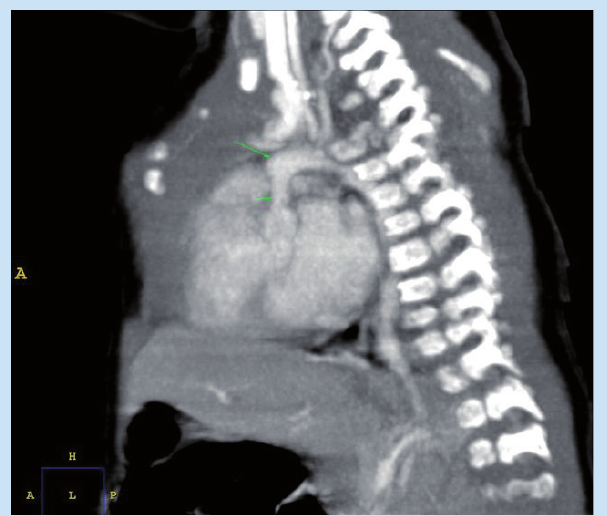
Fig. 3. Sagittal MIP image – demonstrating SVAS (short arrow) and poststenotic dilatation (long arrow).